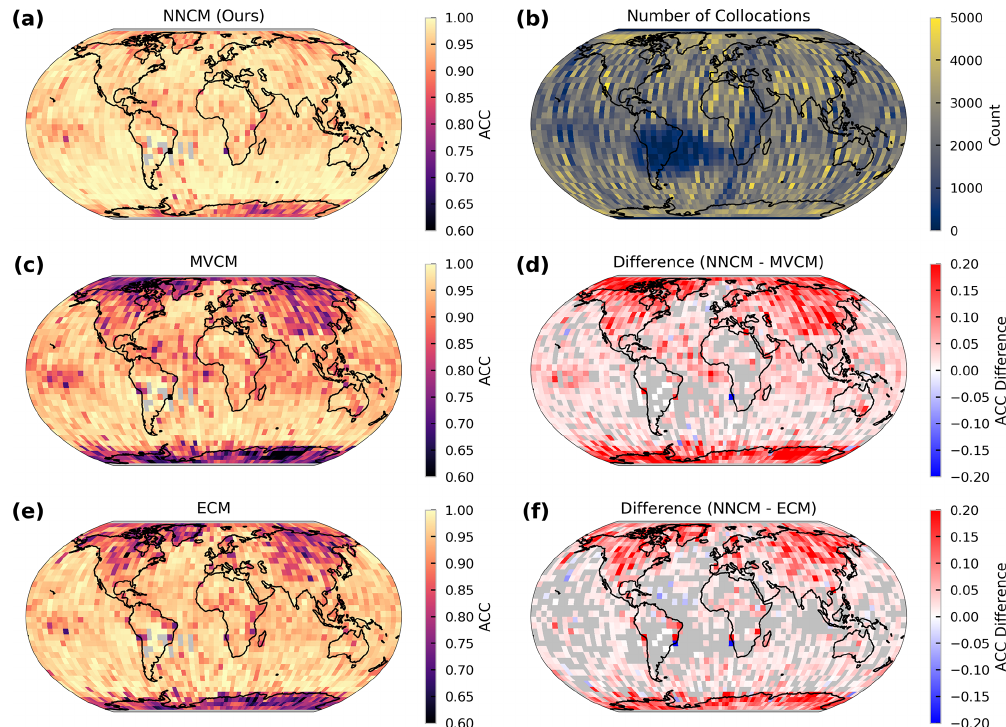
Figure 7. Geographic comparison of the ACC between the three cloud masks on the filtered testing dataset. Each grid cell is 5 ◦ latitude by 5 ◦ longitude. The gap in coverage over South America is due to the removal of low-energy laser shots from the CALIOP datasets. Cells with fewer than 100 collocations are not shown in (a) or (c) – (f) . Differences are only shown where determined significant by McNemar’s test with p values less than